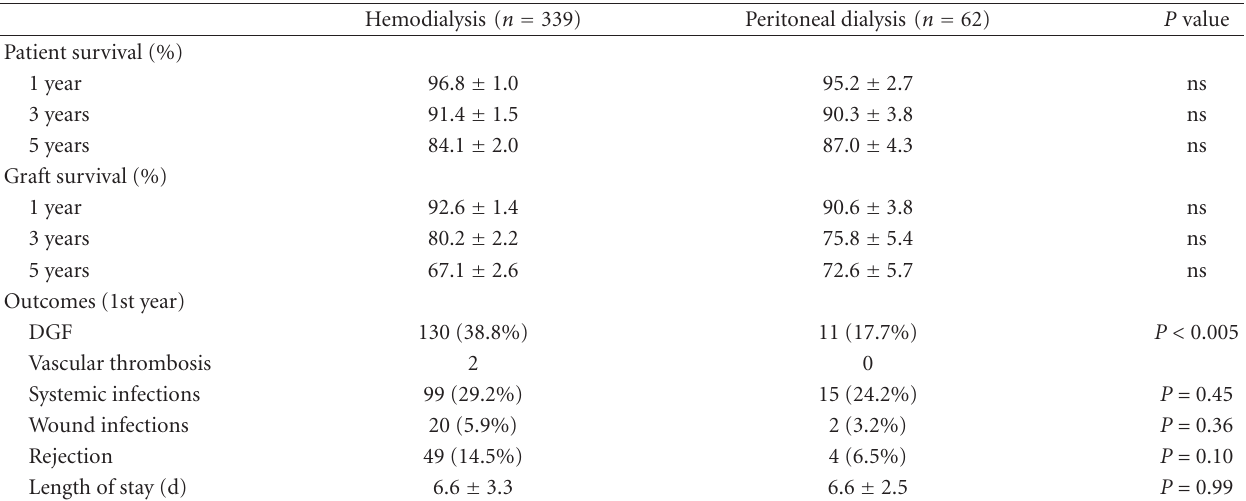
Figure 2: Graft (a) and patient (b) survival curves in African American subgroup with pretransplant peritoneal (PD) and hemodialysis (HD). By Mantel-Cox log rank test, there was no di ff erence in graft ( P = 0 . 46) or patient ( P = 0 . 3) survival. Table 2: Dialysis modality and renal transplant